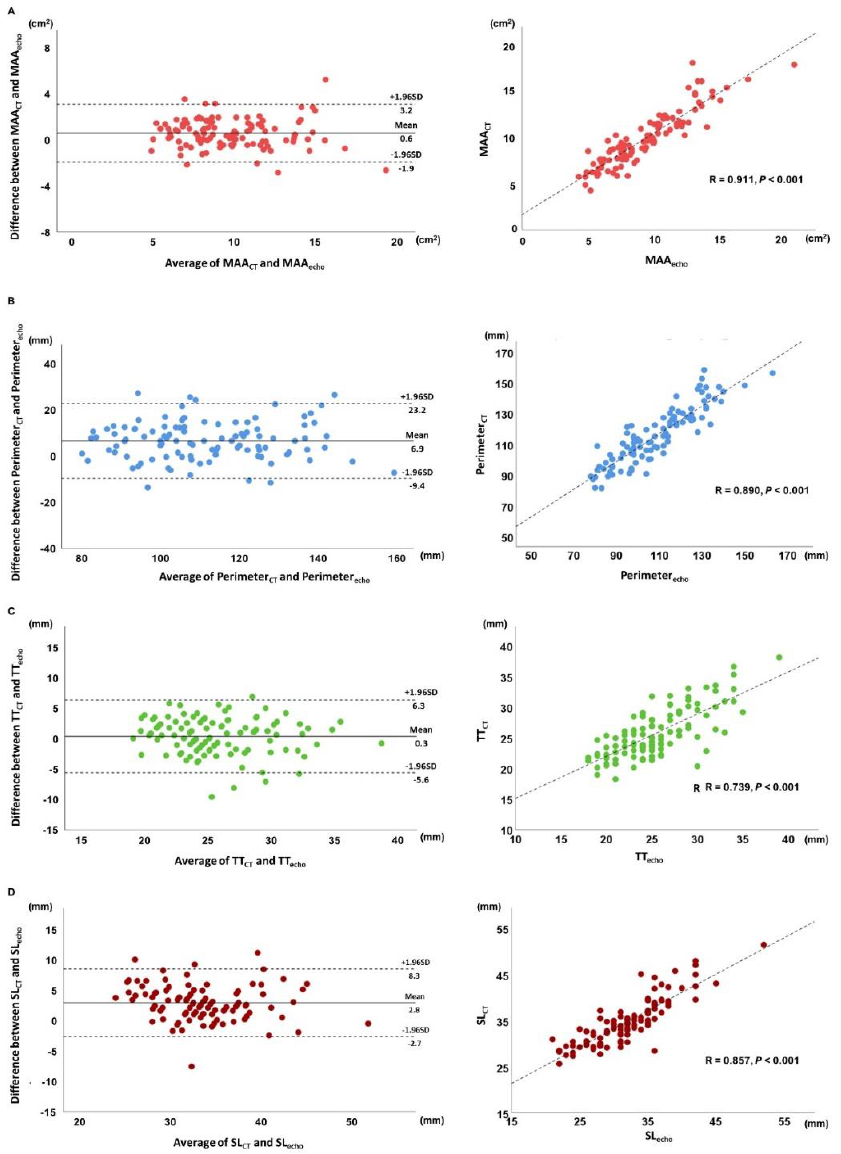
Figure 2. Bland–Altman and scatter plots for MDCT and 3D TEE measurements of MA geometry: ( A ) mitral annular area, ( B ) perimeter, ( C ) inter-trigonal distance, ( D ) septal-lateral difference. CT = computed tomography; MAA = mitral annular area; SD = standard deviation; SL = septal-lateral distance; TT = inter-trigonal distance.